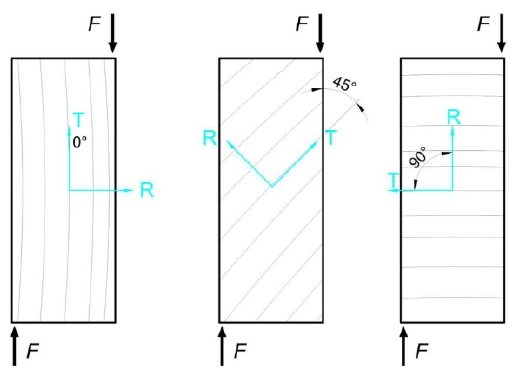
Figure 2. Angle β denoting the grain modes.